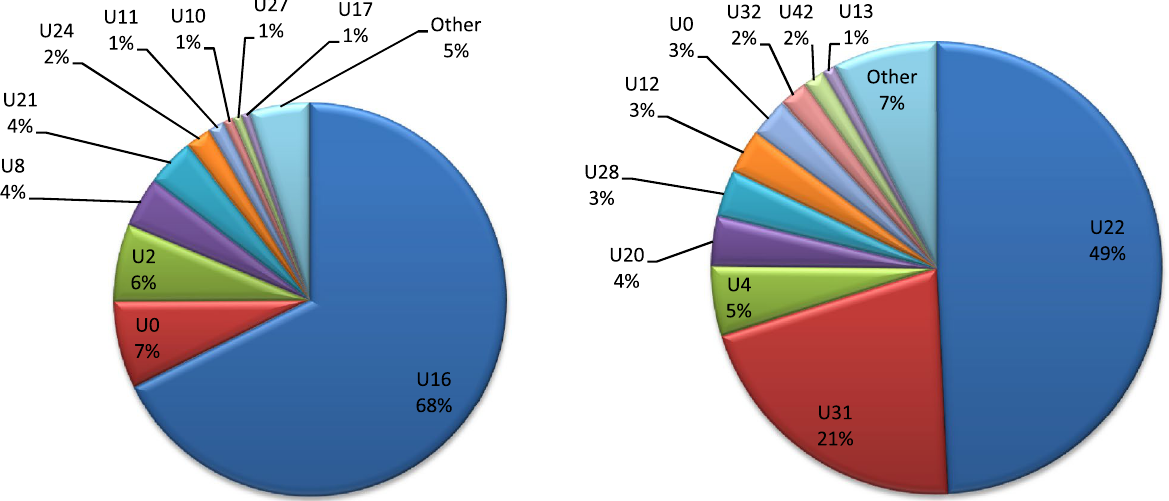
Fig. 5 Percentage of invocations for timer trigger per user, Left-figure: first minute of the day, Right-figure: Last minute of the day